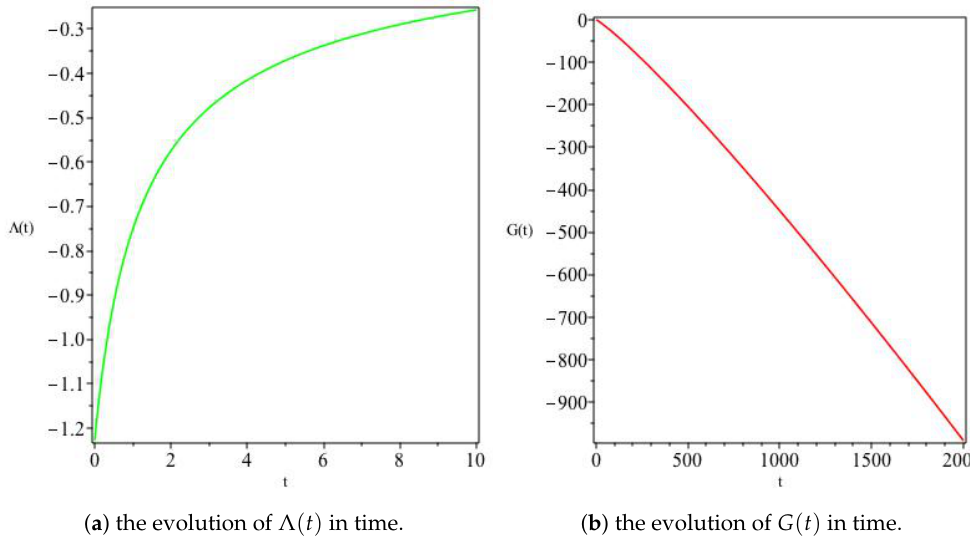
Figure 4. The variation of Λ and G for α = − 2 , β = − 0.5.. Here the opposite behaviour to Figure 3 is observed, namely an increasing Λ and a decreasing G for the choice of model parameters